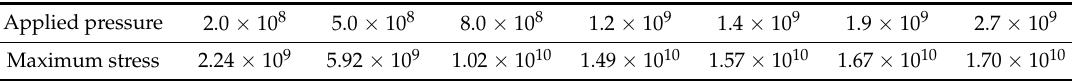
Table 2. Maximum Von Mises stresses under different imprinting pressures (units of Pa).